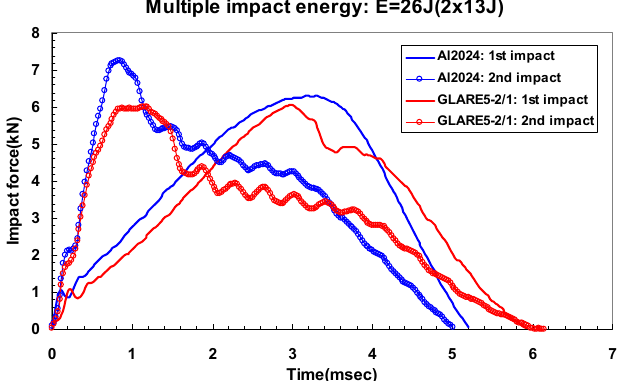
Figure 9. Impact force-time curves of aluminum 2024-T3 and GLARE 5-2/1 for multiple impact CVID case: 26 J (2 × 13 J).